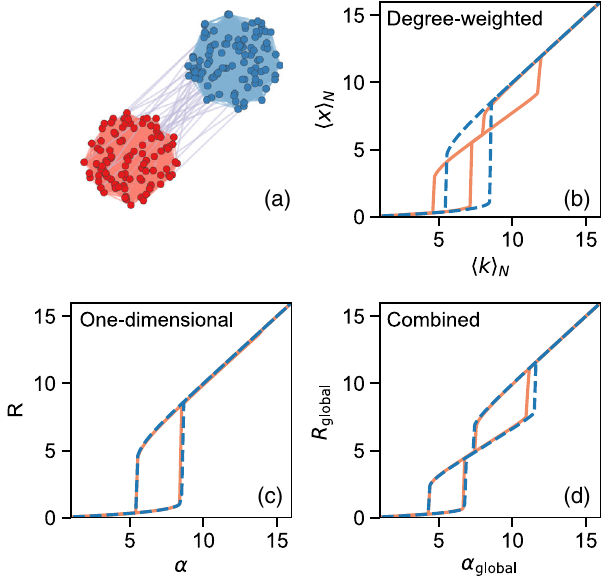
FIG. 4. (a) Schematization of the undirected planted partition network of two communities of 100 nodes each with in-densities p 0 . 4 and p 0 . 7 , and out-density p 3 × 10 − 3 . in ¼ in ¼ out ¼ (b) Average neighbor activity at equilibrium as a function of its structural parameter using the degree-weighted reduction of Gao et al. [9]. (c) Dominant eigenvector-weighted activity R ¼ v T x at equilibrium as a function of the associated eigenvalue α for D the one-dimensional reduction [Eq. (9)]. (d) Combination of the R R = 2 at equilibrium as uncoupled observables R D þ SD Þ global ¼ ð a function of the structural parameter α [see Eq. (30b)]. Solid global lines result from simulations, and dashed lines are theoretical predictions. The dynamics is the Cowan-Wilson model with τ ¼ 1 , μ ¼ 3 [Eq. (2a)].